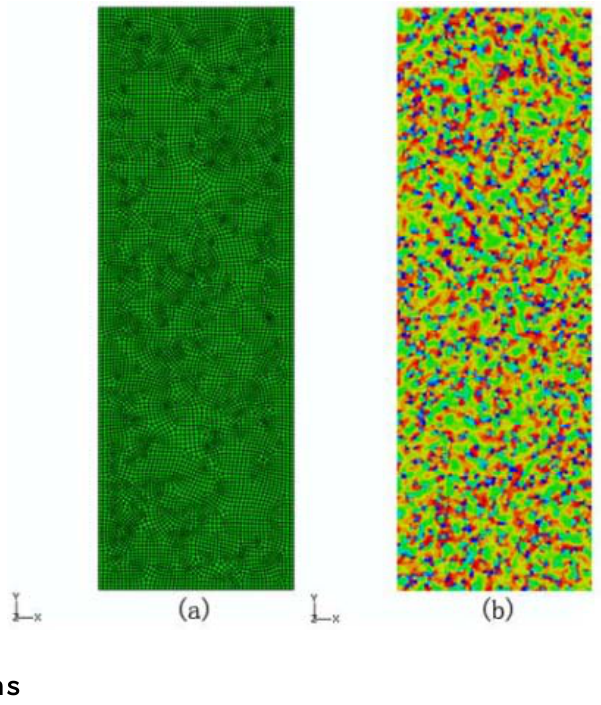
Figure 2. A rectangular sample under plane strain tension and compression: ( a ) finite element mesh and ( b ) the contour of the initial randomly distributed free volume